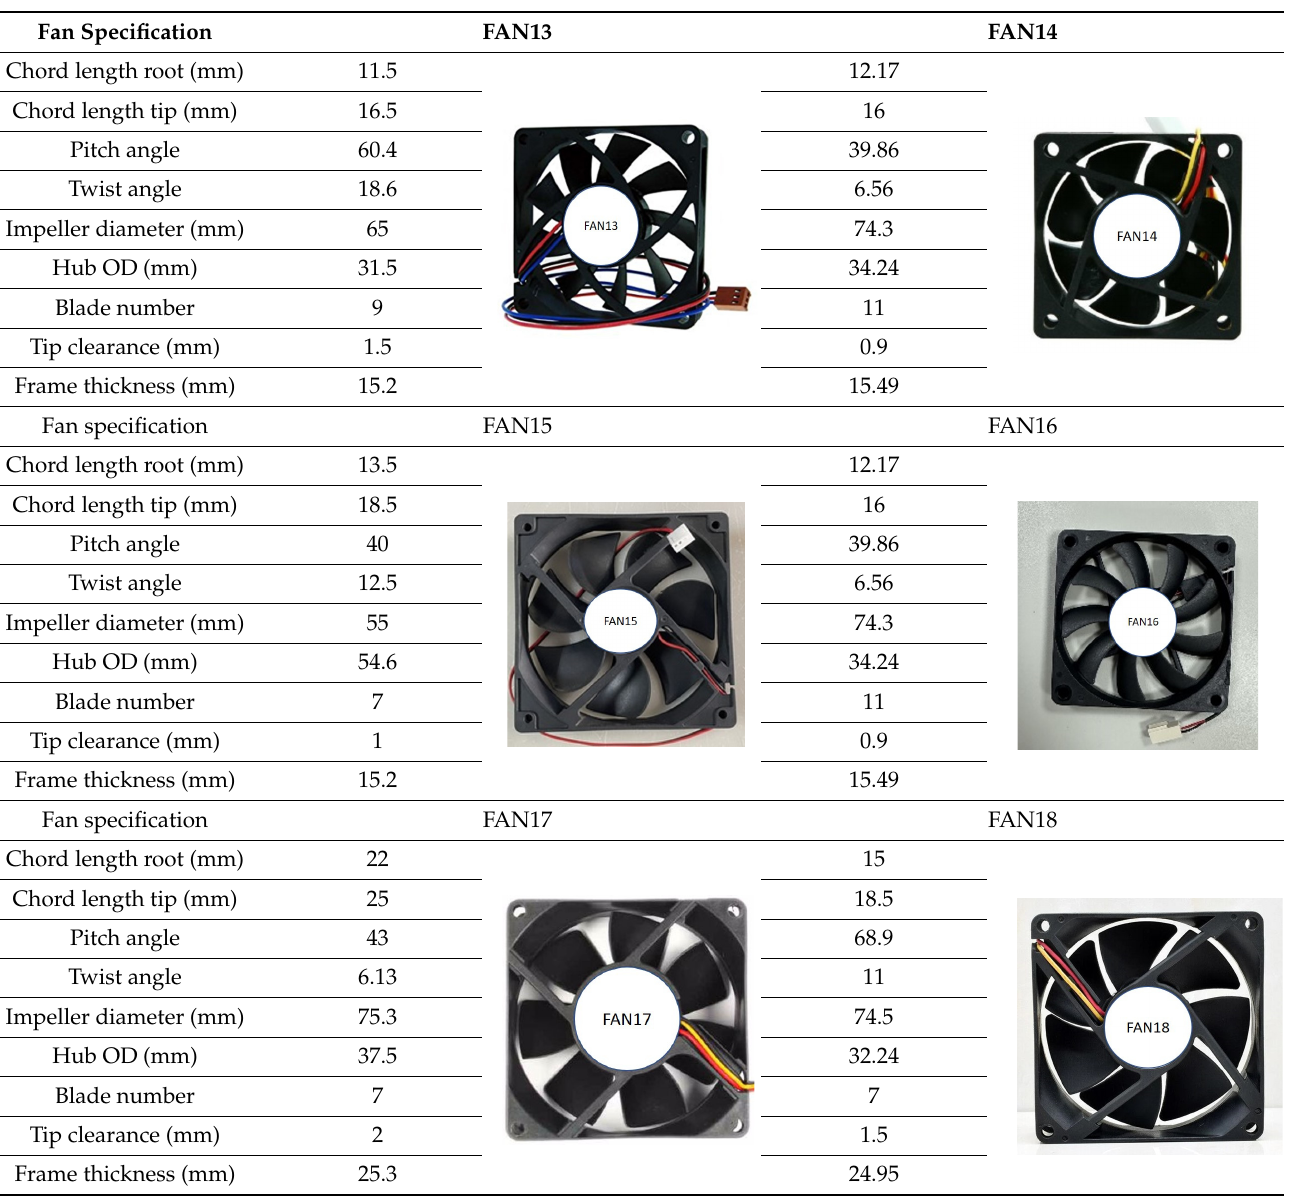
Table 5. Fan characteristics.